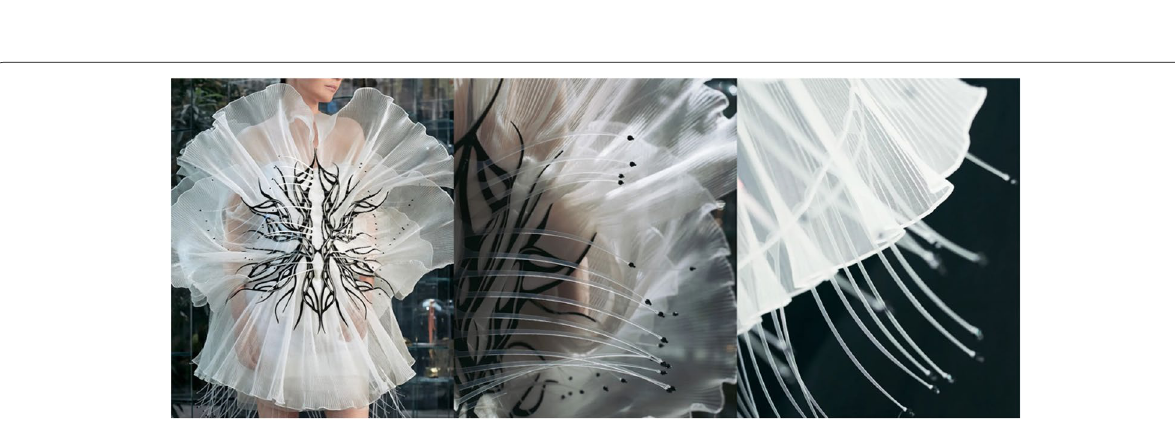
Fig. 35 Clothing designed by Iris van Herpen. 3D printing and cloth simulation algorithms help designers create visually stunning